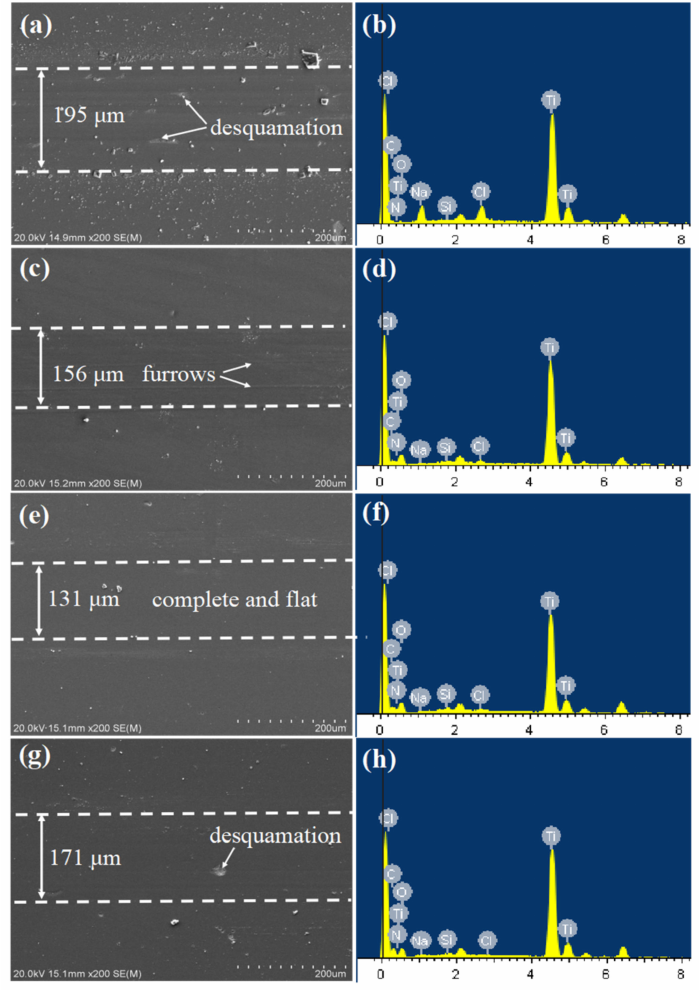
Figure 10. Worn surface and corresponding EDS result of coatings at different bias voltages: ( a , b ) − 50 V; ( c , d ) − 100 V; ( e , f ) − 200 V; ( g , h ) − 300